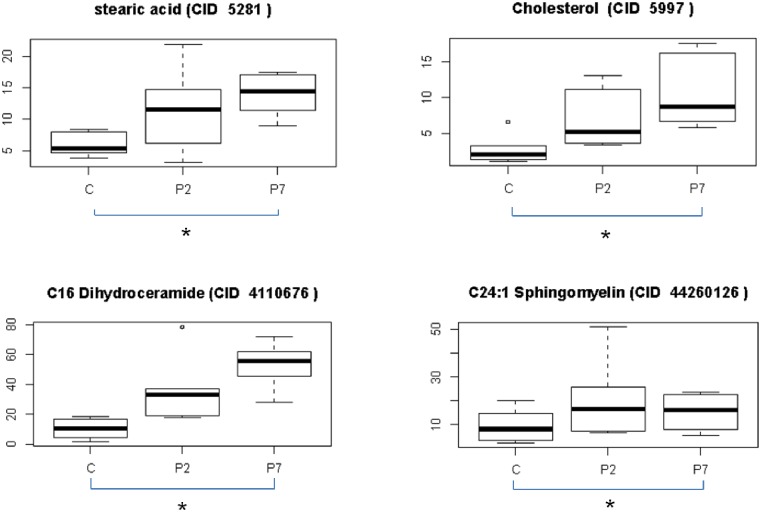
Differentially expressed islet lipids after palmitate treatment for 2 and 7 days.The PubChem Compound Identification (CID) is indicated in each case. Stearic acid and cholesterol were measured in μg, C16 dihydroceramide and C24:1 sphingomyelin were measured in pmol. *P-value of less than 0.05.